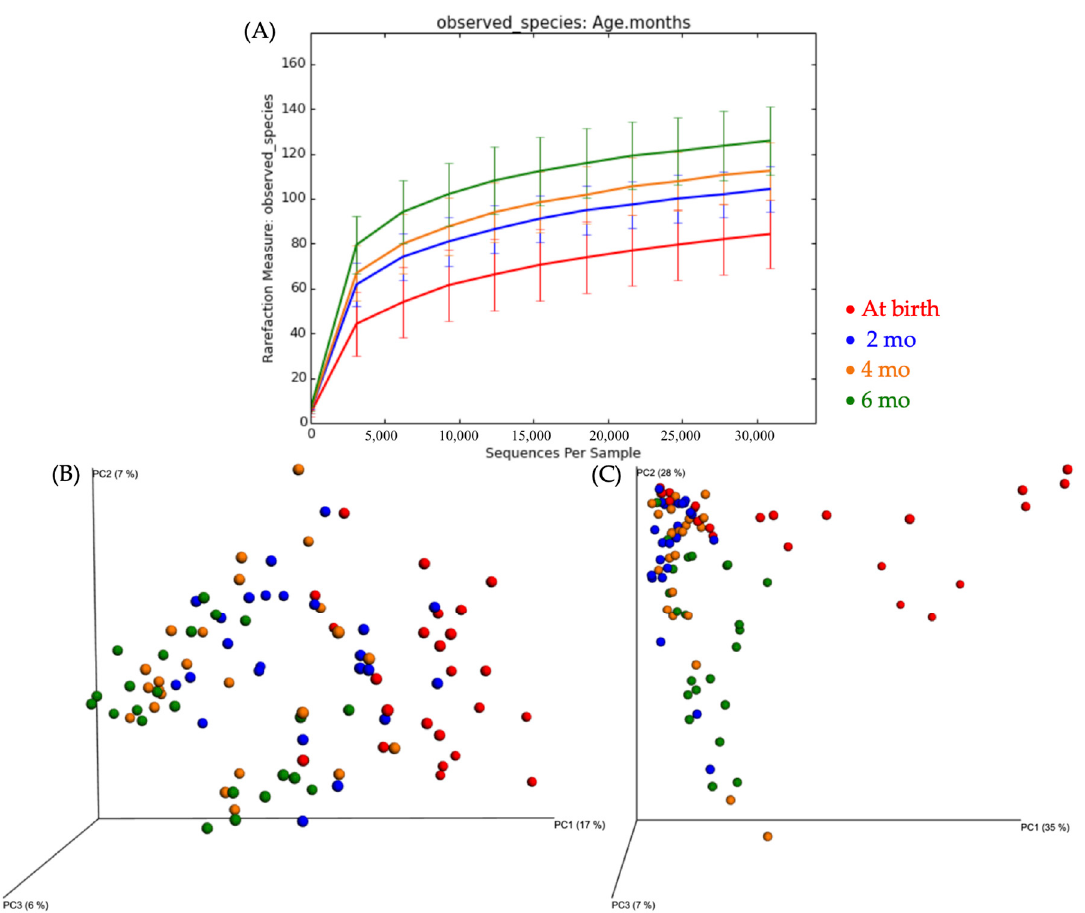
Figure 1. ( A ) Rarefaction curves showing bacterial species richness based on infant age. Mean number of operational taxonomic units (OTU) per subject for infant age. ( B ) Unweighted principal coordinates analysis (PCoA) plot of identified bacterial OTUs, shows plot for infant age. ( C ) Weighted PCoA plot of identified bacterial OTUs, shows plot for infant age.